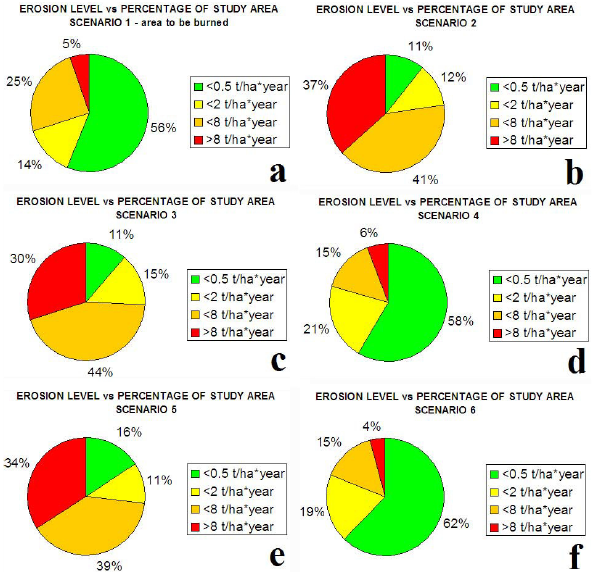
Fig. 6. Erosion levels in the study area under the six different sce- narios.